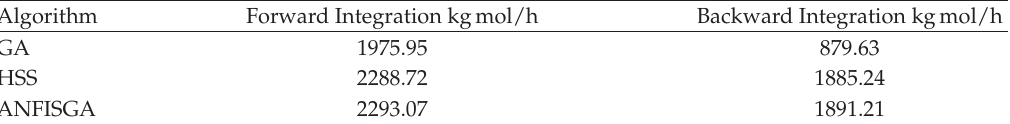
Table 4: Best results for GA, HSS, and ANFISGA